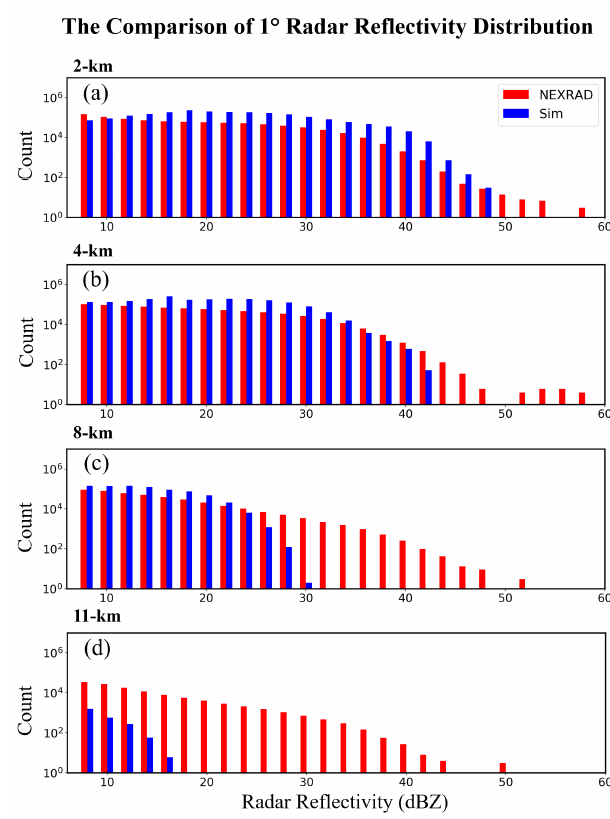
Figure 6. Comparison of radar reflectivity histograms at 1 ◦ scale between NEXRAD observations (red bars) and the simulations (blue bars) at the vertical levels of 2, 4, 8, and